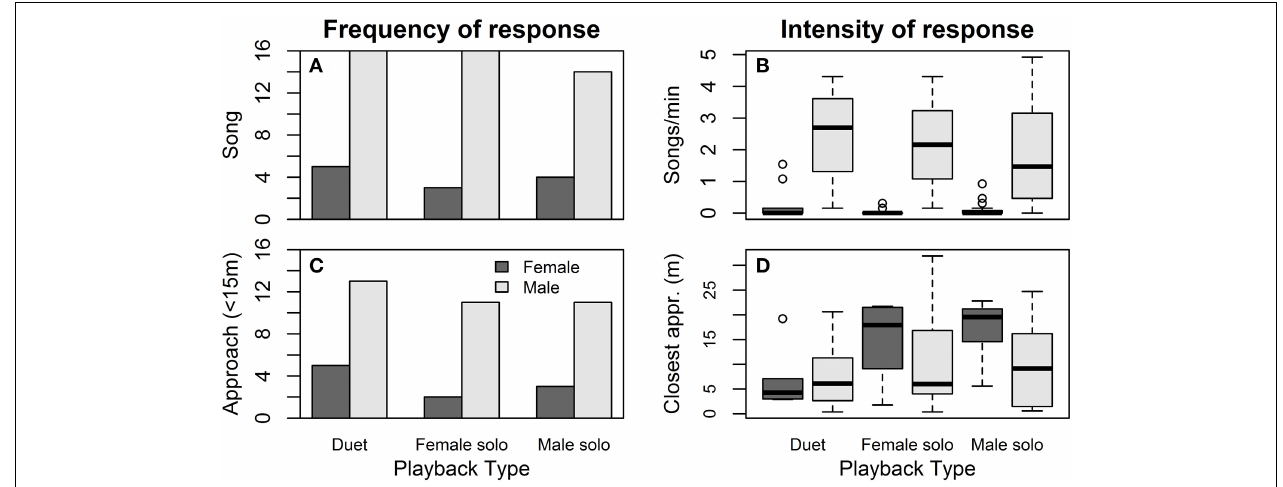
FIGURE 4 | Effect of playback on song and approach responses. Female (dark gray) and male (light gray) responses to duet-, female solo-, and male solo-playback in terms of the number of birds